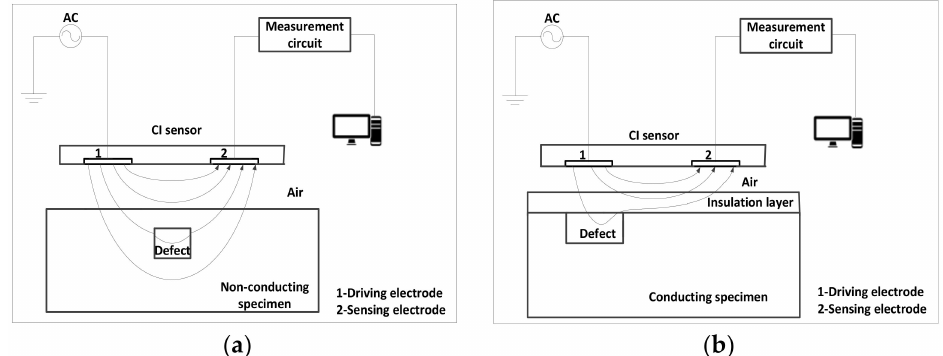
Figure 1. Detection principle of CI: ( a ) CI sensor inspecting the non-conducting specimen; ( b ) CI sensor inspecting the conducting specimen covered by an insulation layer; CI: capacitive